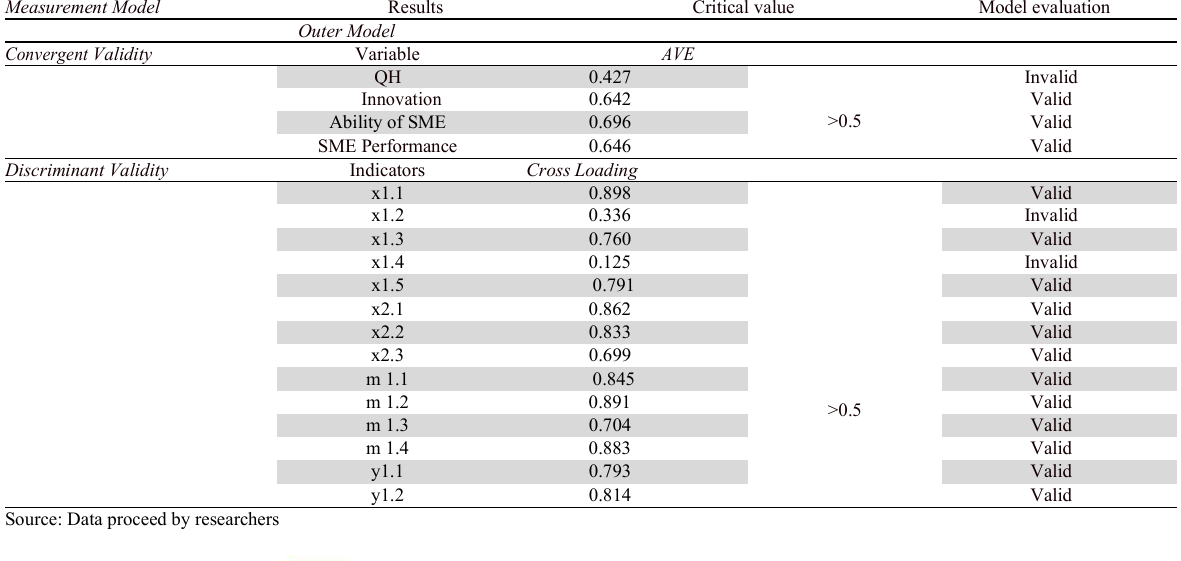
Measurement initial outer model Spain craft sub sector Measurement Model